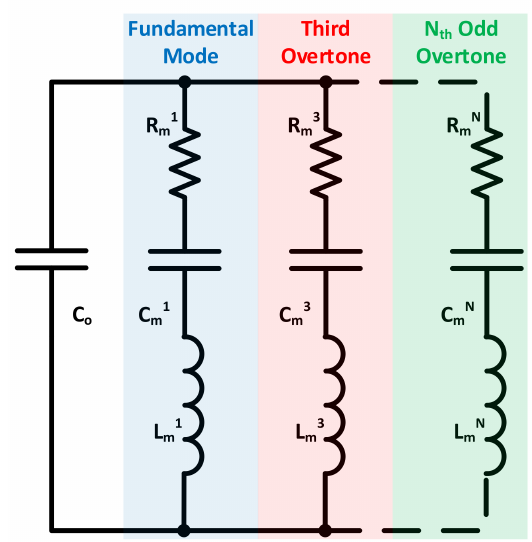
Figure 8. Extended unloaded BVD model, including parallel harmonic overtones